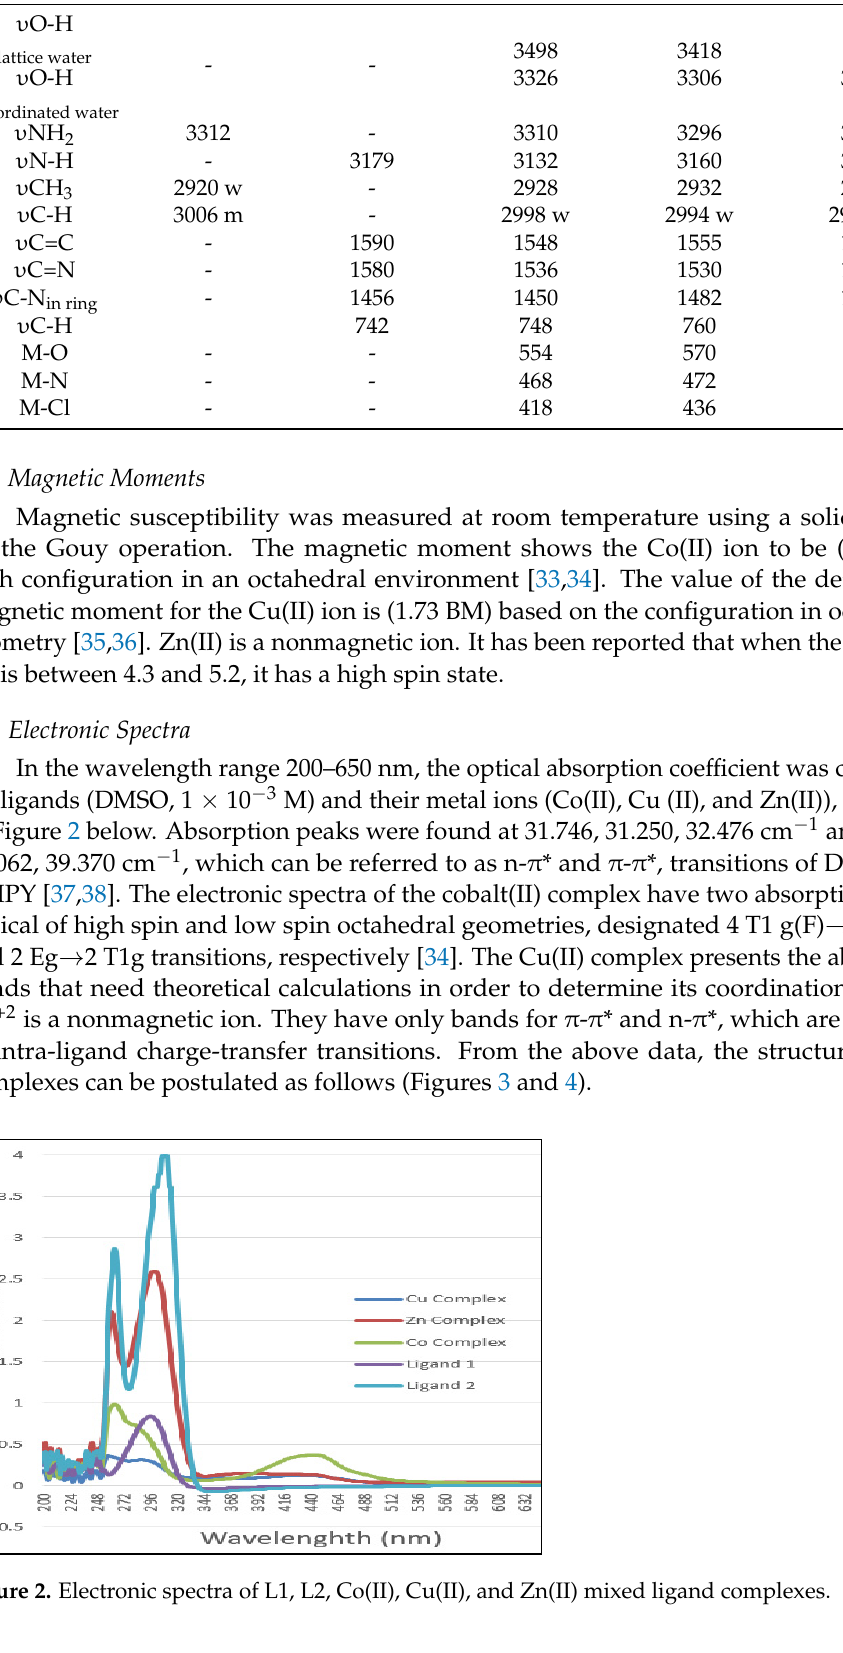
Figure 3. Structure of [M(AMPY)(DAPY)Cl 2 (H 2 O)] M = Co(II), Cu(II), and Zn(II). Figure 4. A perspective view of the complete coordination around Co(II) complex. 3.4. Theoretical Study Molecular modeling was performed for all compounds using the density functional theory DFT/B3LYP to study the structures and the frontier molecular orbitals (Figure 5). The mode of bonding is pentacoordinate for Cu and hexacoordinate for Zn and Co. Se- lected bond lengths (Å) calculated at B3LYP are presented in Table 2. Zn is coordinated to one nitrogen of L1 (Zn-N = 2.10Å) and to two nitrogens of L2 (2.28 and 2.38Å). Co is coor- dinated to one nitrogen of L1 (Co-N = 2.00 Å) and to two nitrogens of L2 (2.00 and 2.37 Å).